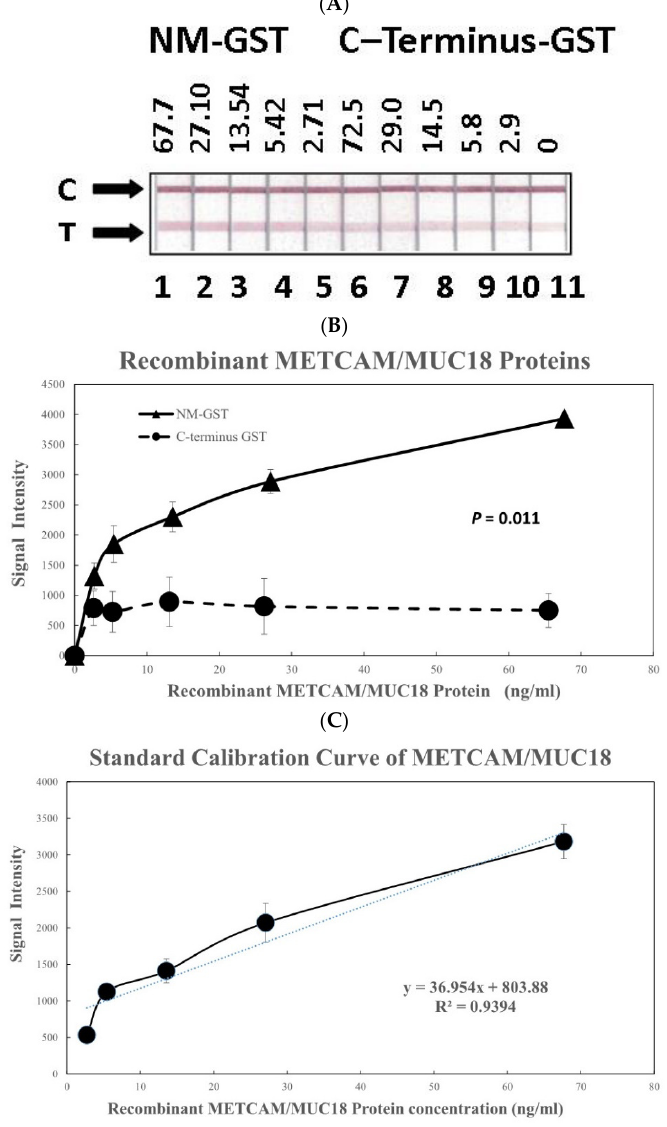
Figure 5. ( A ) Recombinant std protein image combo2, ( B ) Positive and negative controls combo2, ( C ) Calibration curve combo2. Establish the calibration curve from recombinant METCAM/MUC18 proteins as determined by a modified LFIA method by using home-made biotinylated chicken antibody and nanogold-conjugated rabbit antibody (EPP11278). ( A ) shows the intensities of the recombinant METCAM/MUC18 proteins, the positive control protein, NM-GST, and the negative control protein, C-terminus-GST, at different concentrations. C stands for control lines and T for test lines. ( B ) shows quantitative results of the intensities of the two recombinant METCAM/MUC18 proteins at different concentrations. ( C ) shows the standard calibration curve obtained by subtracting the intensity of the negative control protein from the positive control